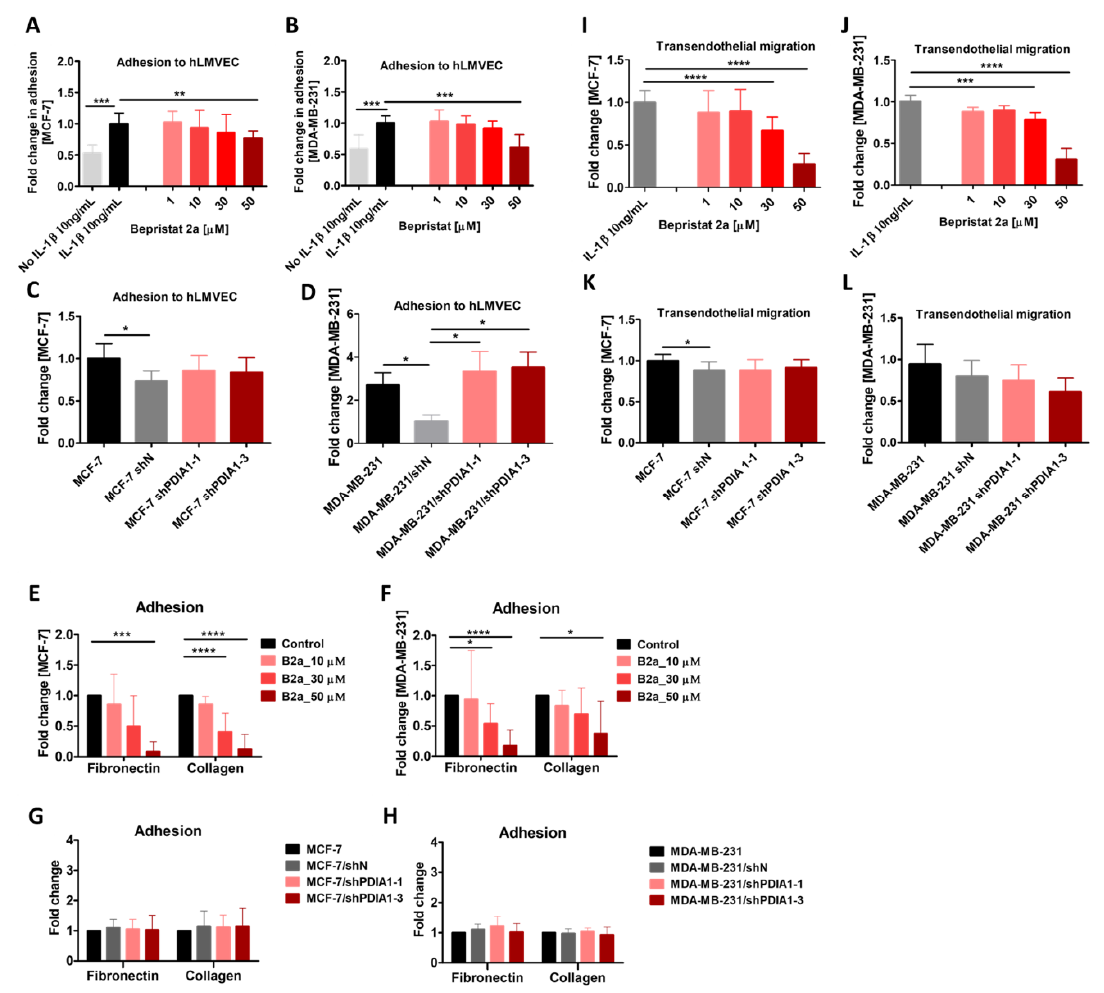
Figure 3. Effect of PDIA1 inhibition on adhesion of breast cancer cells to the endothelium, collagen type I and fibronectin and their transendothelial migration across hLMVEC monolayer. Effect of bepristat 2a on adhesion of MCF-7 ( A , E ) and MDA-MB-231 ( B , F ) cells to hLMVEC, collagen type I and fibronectin, respectively, and MCF-7 ( C , G ) and MDA-MB-231 ( D , H ) cells transduced with lentiviral vectors carrying short hairpin RNA (shRNA) against PDIA1 or negative sequence after selection with puromycin in regarding to wild type cell line. Transendothelial migration of MCF-7 ( I ) and MDA-MB-231 ( J ) cells treated with bepristat 2a and MCF-7 ( K ) and MDA-MB-231 ( L ) sublines with silenced PDIA1 expression across hLMVEC monolayers. Data represent mean ± SD of three independent experiments. Statistical analysis was performed using one-way ANOVA followed by Dunnett’s multiple comparisons test or nonparametric Kruskal–Wallis followed by Dunn’s multiple comparisons test (* p = 0.05, ** p = 0.01, *** p = 0.001, **** p = 0.0001).